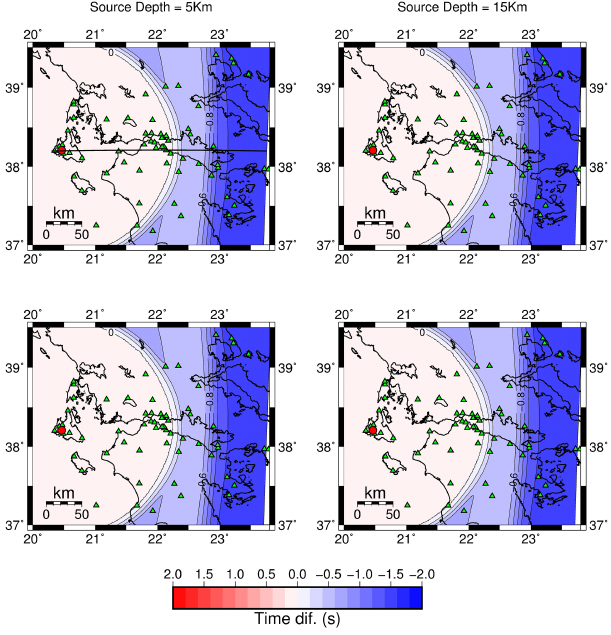
Figure 5. Time differences of P -wave (the two panels in the upper row) and S -wave (the two panels in the lower panel) arrivals be- tween synthetic data calculated on the basis of the 1-D model and data collected using the 2-D model (based on the same 1-D model but with a non-horizontal Moho boundary). Earthquake focal depths of 5km (left column) and 15km (right column) are represented. The hypothetical epicenter is shown as a red circle. The errors imported in the case which does not take into account the Moho structure can be significant at long distances.